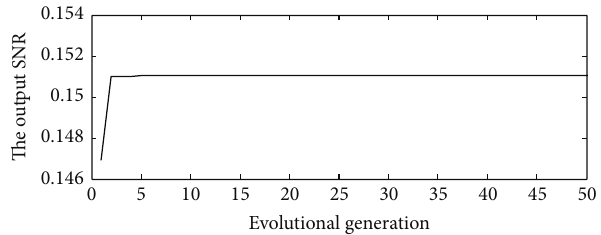
Figure 3: The optimal convergence curve of PSO algorithm.